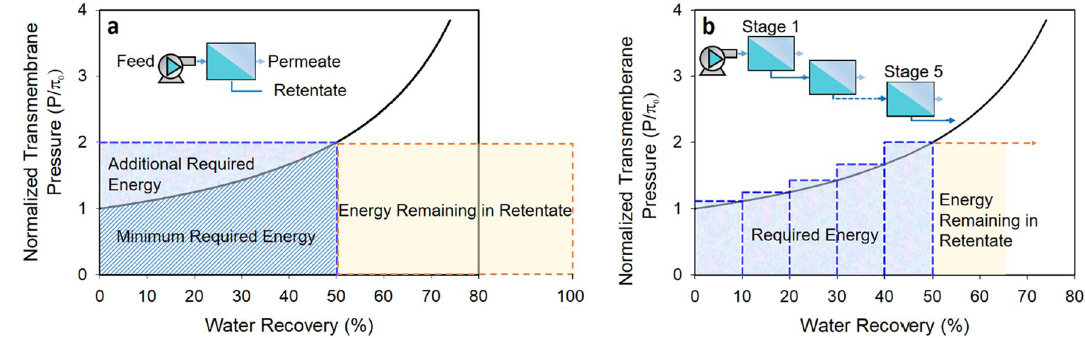
Fig. 1 ( a ) Theoretical transmembrane pressure normalized to the energy and additional required energy for 50% recovery. ( b ) The nor- = 30.343 bar) malized transmembrane pressure for a five-stage RO with 10% recov- osmotic pressure of the feed seawater ( 𝜋 0 for single- ery at each stage. The retentate pressure is increased from one stage stage constant pressure RO with 50% recovery. The shaded area is the SE to the next. The area of the rectangles is the required energy, which is thermodynamic minimum required energy min . The blue area on the sum of the minimum required energy and the additional required top of the minimum pressure curve represents the additional required energy in the cross-flow RO process. The energy remaining in the pressurized retentate is equal to the sum of the minimum required